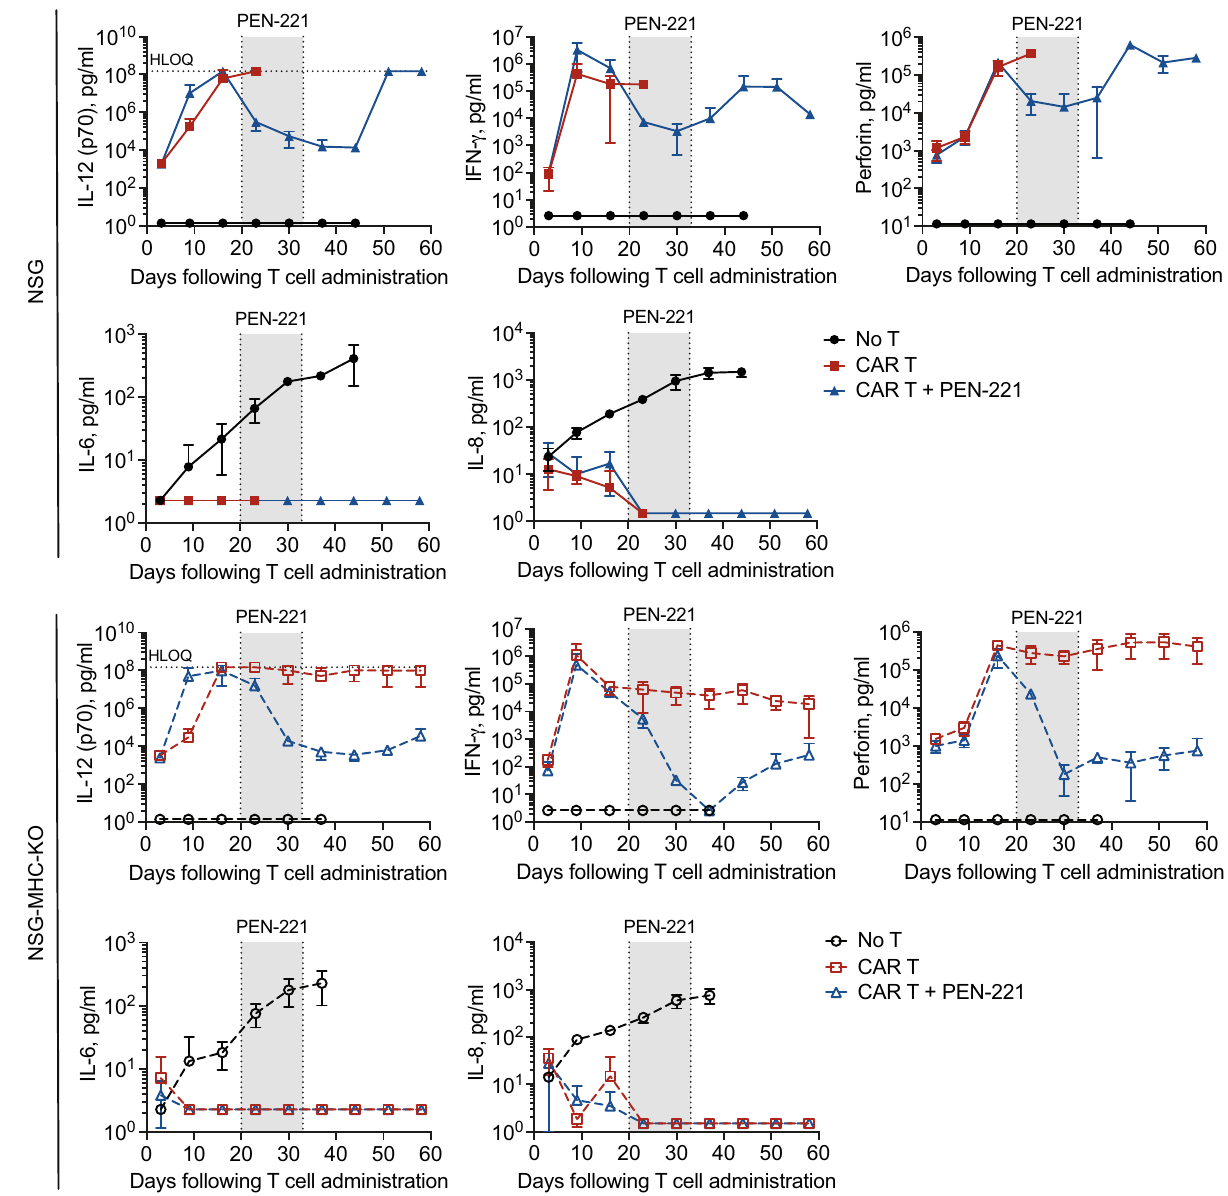
Figure 5. Serum cytokine analysis corroborates the prompt elimination of CAR T cells by PEN-221. Serum cytokines were measured on a weekly basis for 60 days post CAR T cell infusion. Data represent mean ± SD of 3 mice per cohort. No T, no CAR T cell treatment. HLOQ, higher limit of